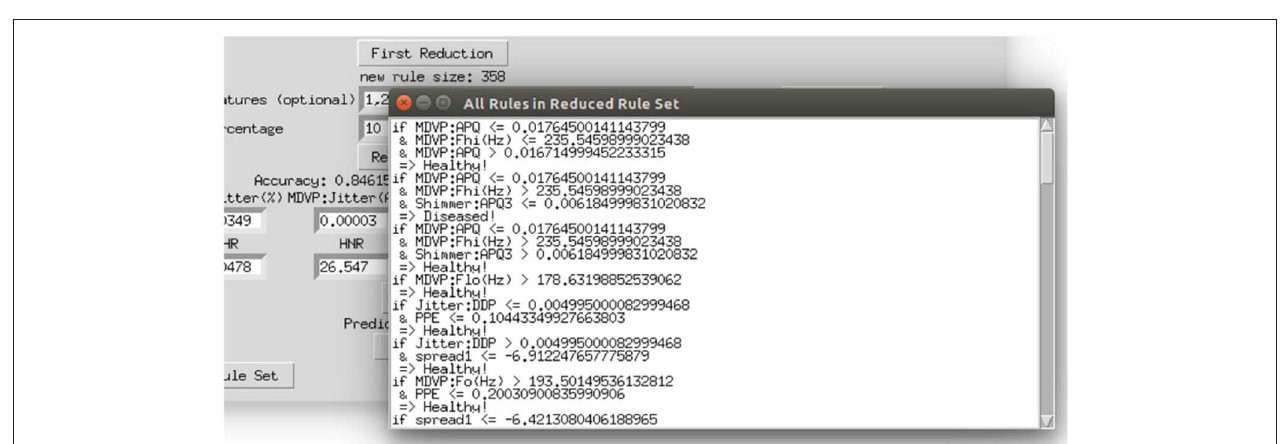
FIGURE 8 | Graphical interface for the clinical decision support system, here applied to the Speech Data Set.